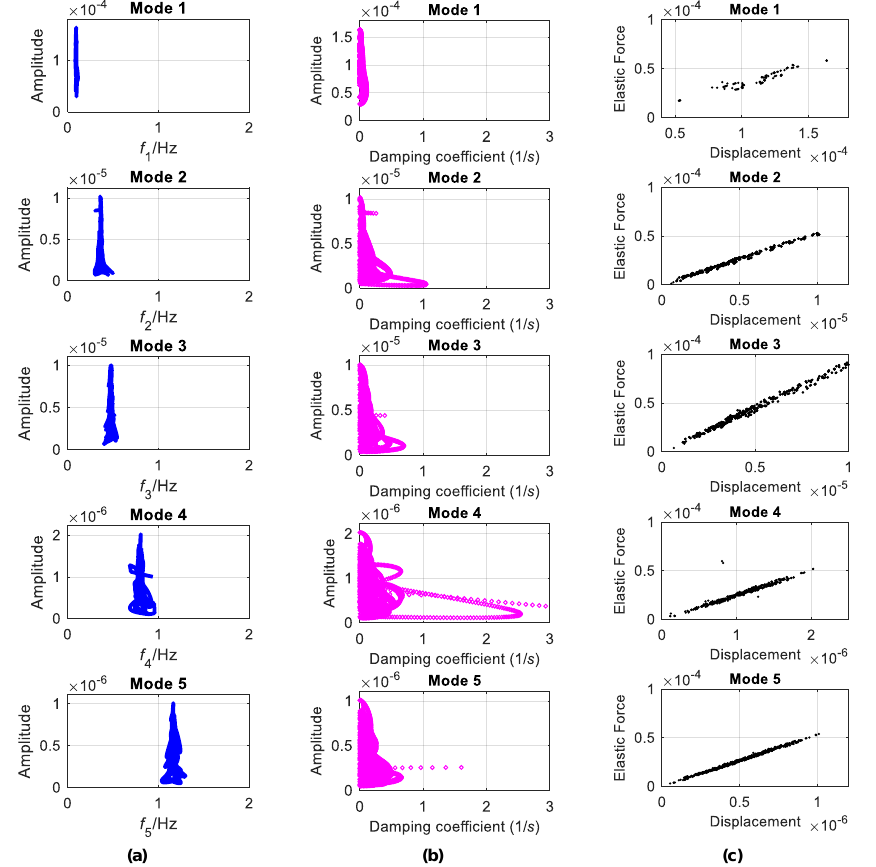
Figure 13. Linear characteristics identified from the signal mono-components of Canton Tower: ( a ) backbones; ( b ) damping coefficients; ( c ) elastic forces.